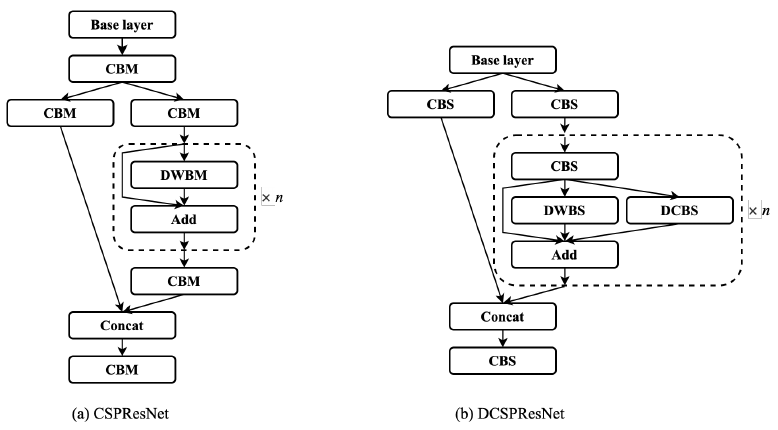
Figure 8. Network structure of CSPResNet and DCSPResNet. CBM consists of convolution, batch normalization, and the Mish activation function. DWBM consists of depth-wise separable convolution, batch normalization, and the Mish activation function. The CBS, DWBS, and DCBS structures are shown in Figure 9.